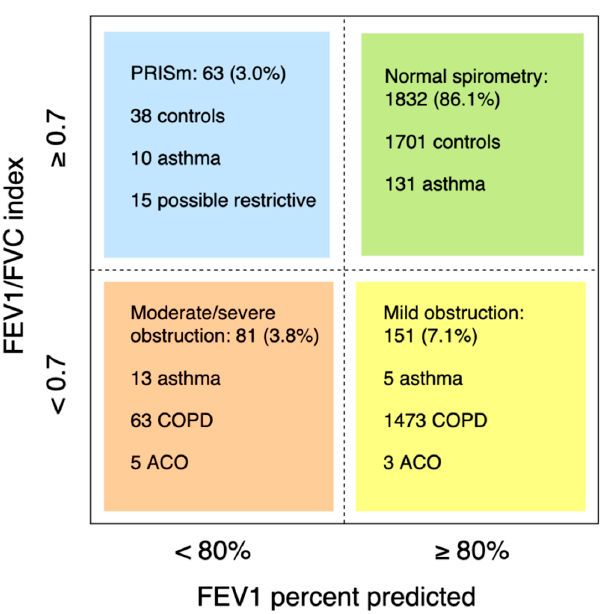
Figure 1. Flowchart of participants.